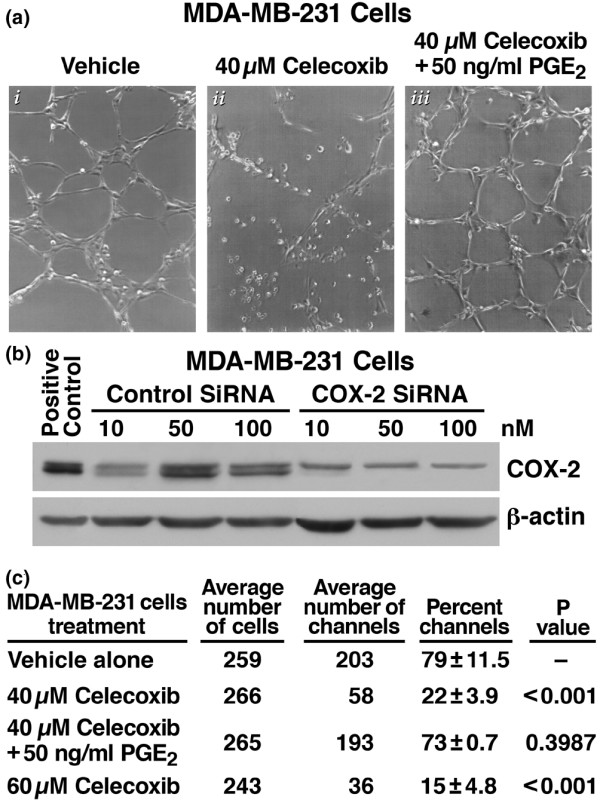
COX-2 inhibition by celecoxib or specific siRNA inhibits vascular channel formation. (a) Phase contrast images show vascular channel formation in growth factor reduced matrigel of MDA-MB-231, treated with vehicle or 40 mmol/l celecoxib. Images were captured 48 hours after plating using a phase contrast microscope. (part i) With vehicle treatment, MDA-MB-231 cells form well differentiated tubular structures. (part ii) With celecoxib treatment, differentiation into channels was significantly reduced in MDA-MB-231 cells. (part iii) Addition of 50 ng/ml PGE2 to MDA-MB-231 cells treated with 40 μM celecoxib could reverse the inhibitory effect of celecoxib. (b) COX-2 expression decreases in MDA-MB-231 cells with siRNA treatment. COX-2 protein expression was measured by Western blot. Treatment with a COX-2 siRNA for 48 hours significantly inhibited COX-2 expression at siRNA concentrations of 10, 50, and 100 nmol/l. Data shown are representative of three independent experiments. (c) Inhibition of vascular channel formation in MDA-MB-231 cells with celecoxib and COX-2-specific siRNA treatment. Quantitative analysis of vascular channel formation: the number of vascular channels was determined by counting the number of connected cells in five randomly selected fields, using 200 × magnification, and dividing that number by the total number of cells in the same field. Raw data from five standardized fields for each treatment from three separate experiments are shown. Treatment with 40 and 60 mmol/l celecoxib and treatment with a 50 nmol/l concentration of COX-2 siRNA for 48 hours caused significant decrease in the number of channels formed by MDA-MB-231 cells, and addition of 50 ng/ml of PGE2 was able to reverse the effect observed with treatment with 40 mmol/l celecoxib. P values represent significant difference between vehicle control and celecoxib treatment. COX, cyclo-oxygenase; PG, prostaglandin; siRNA, small interfering RNA.